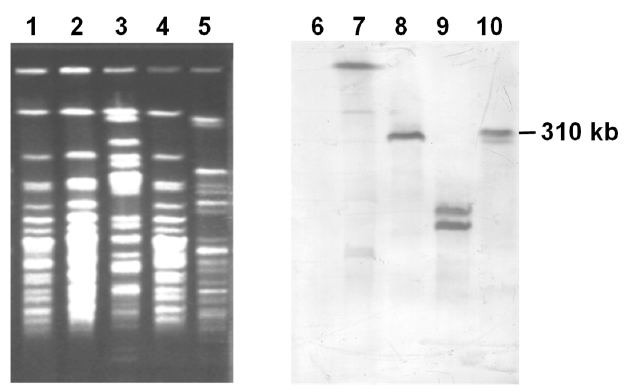
Figure 9. Conjugative transfer of the bph genes from P. putida AC30Bph + and P. putida KT2440Bph + into P. putida F39 / D. Genomic DNA was digested with Spe I, applied to pulse field gel electrophoresis, and subjected to Southern blot analysis. The bphA1 DNA of KF715 was used as a probe. Lanes 1 and 6, F39 / D; lanes 2 and 7, F39 / DBph + transconjugant from AC30Bph + ; Lanes 3 and 8, AC30Bph + ; Lanes 4 and 9, F39 / DBph + transconjugant from KT2440Bph + ; and Lanes 5 and 10, KT2440Bph +